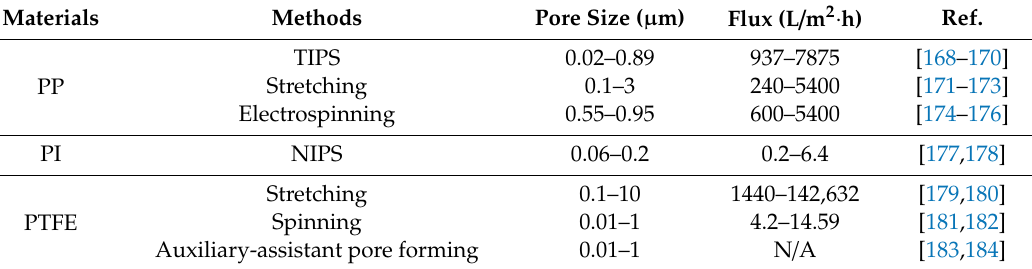
Table 8. Properties of PP, PI, and PTFE polymer